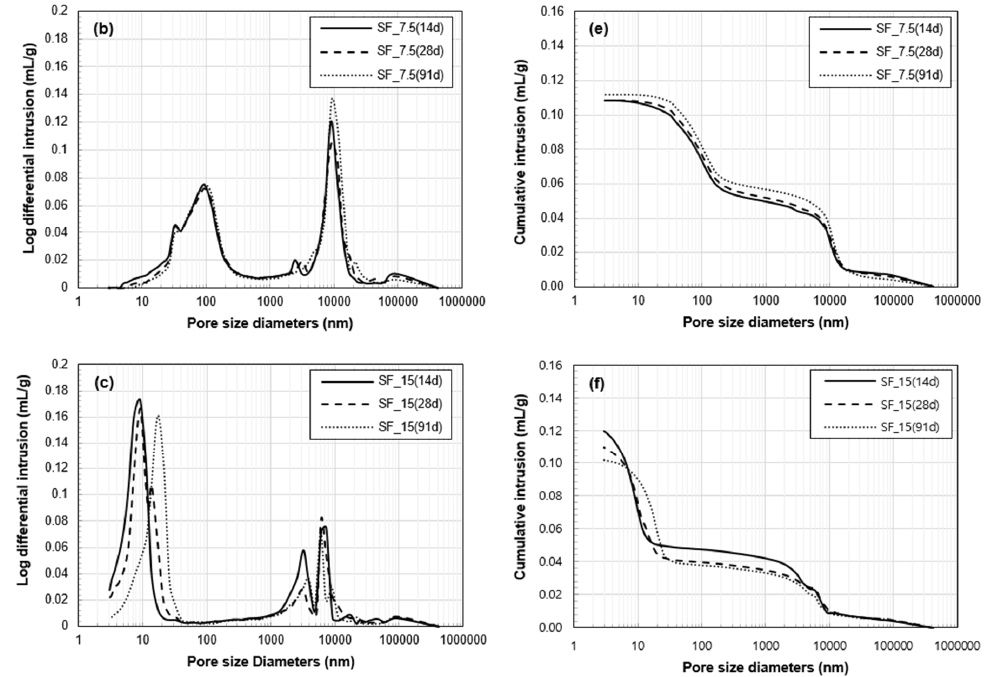
Figure 5. Porosimetry of kaolinite clay based mortar: log differential intrusions of Ref ( a ), SF_7.5 ( b ), and SF_15 ( c ), and cumulative pore volume of Ref ( d ), SF_7.5 ( e ), and SF_15 ( f ).